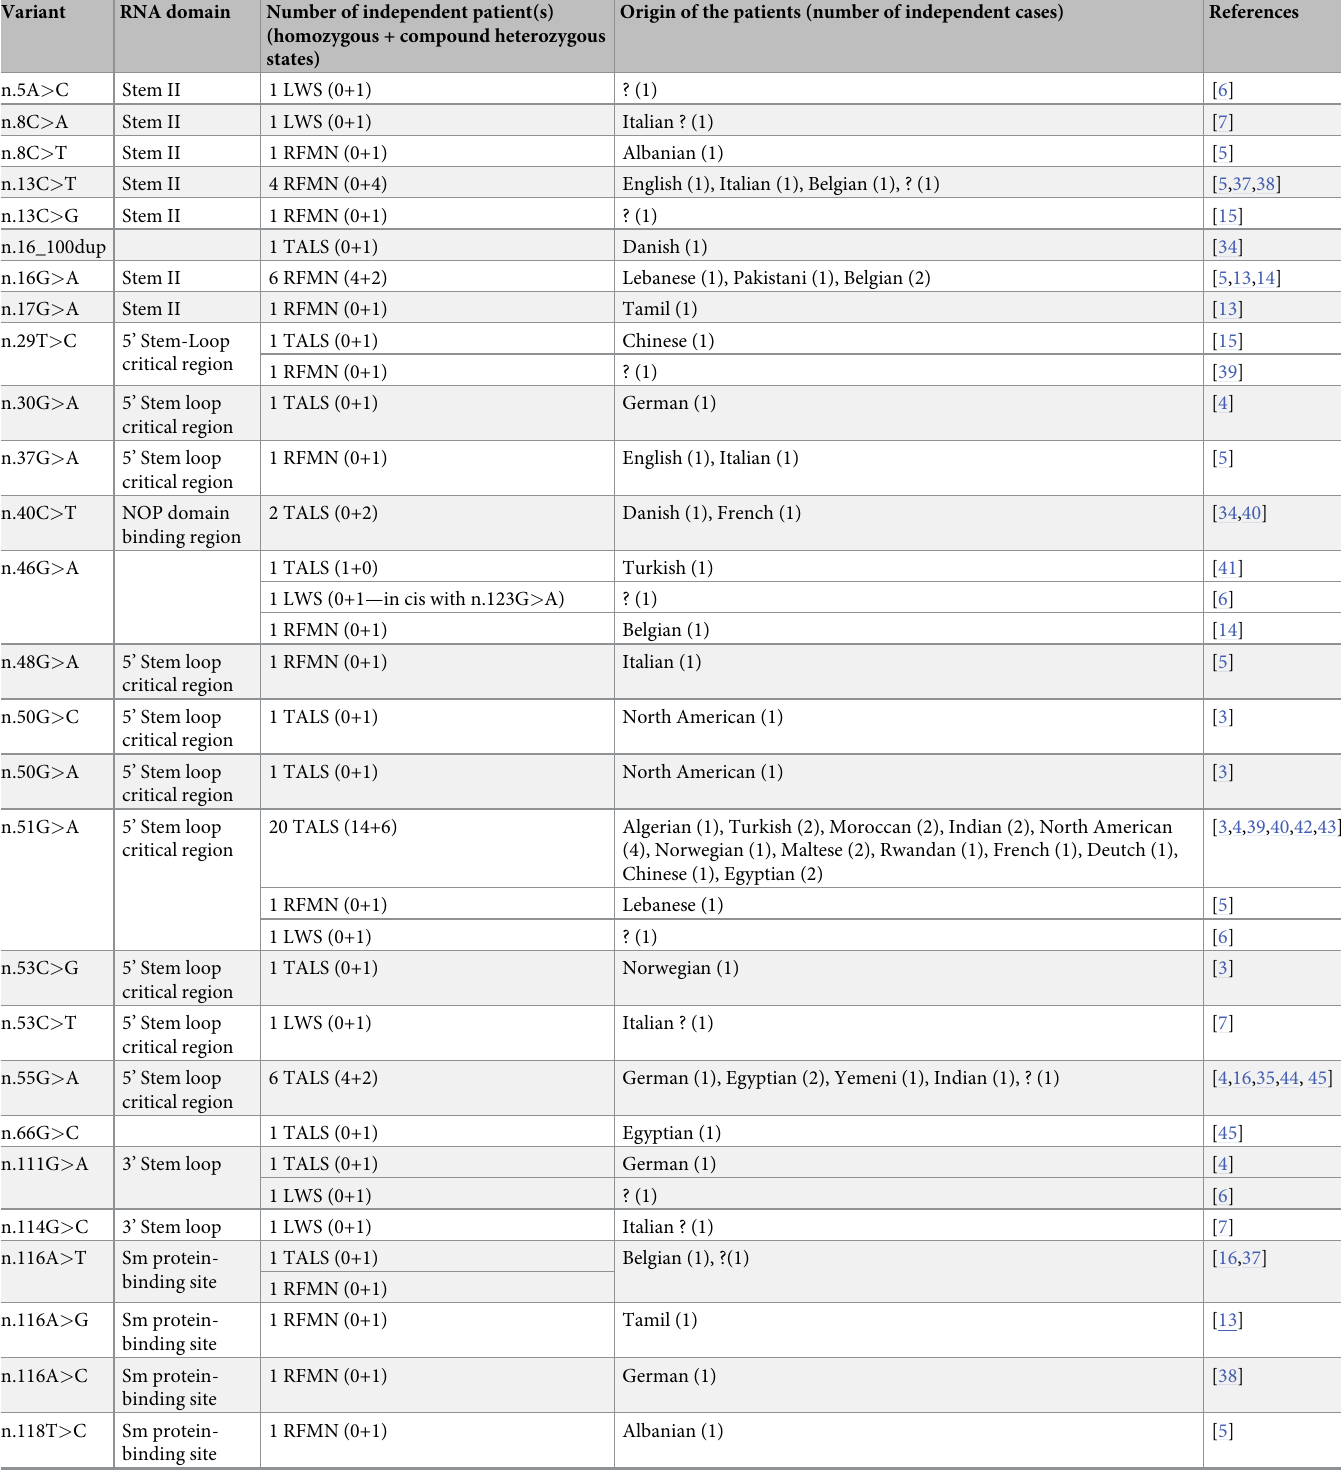
Table 1. Summary of the published disease-associated RNU4ATAC